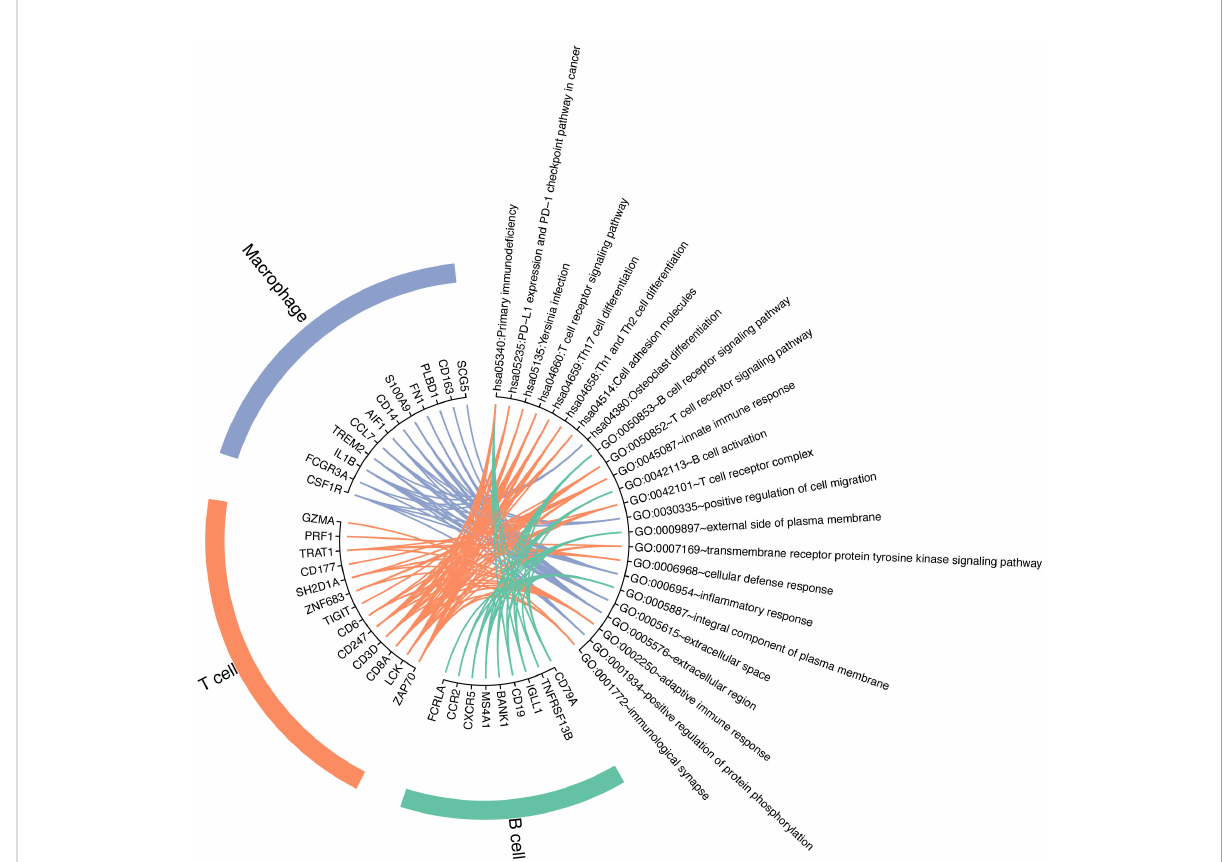
FIGURE 7 GO and KEGG enrichment analysis of differentially expressed genes in immune cell